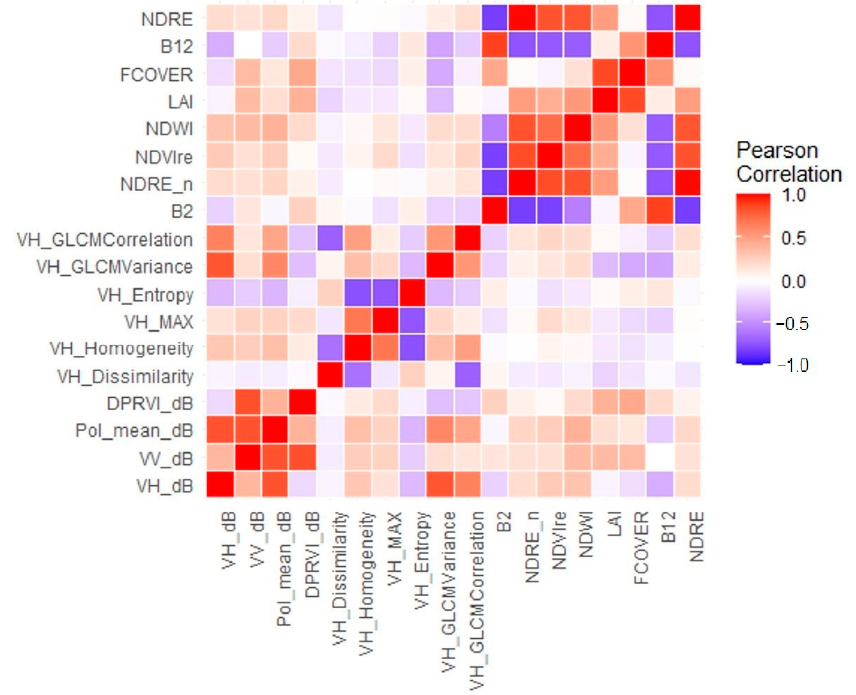
Figure 4. Pearson’s correlation matrix between the predictor variables and field-measured total stem biomass (TSB) after collinearity rejection.